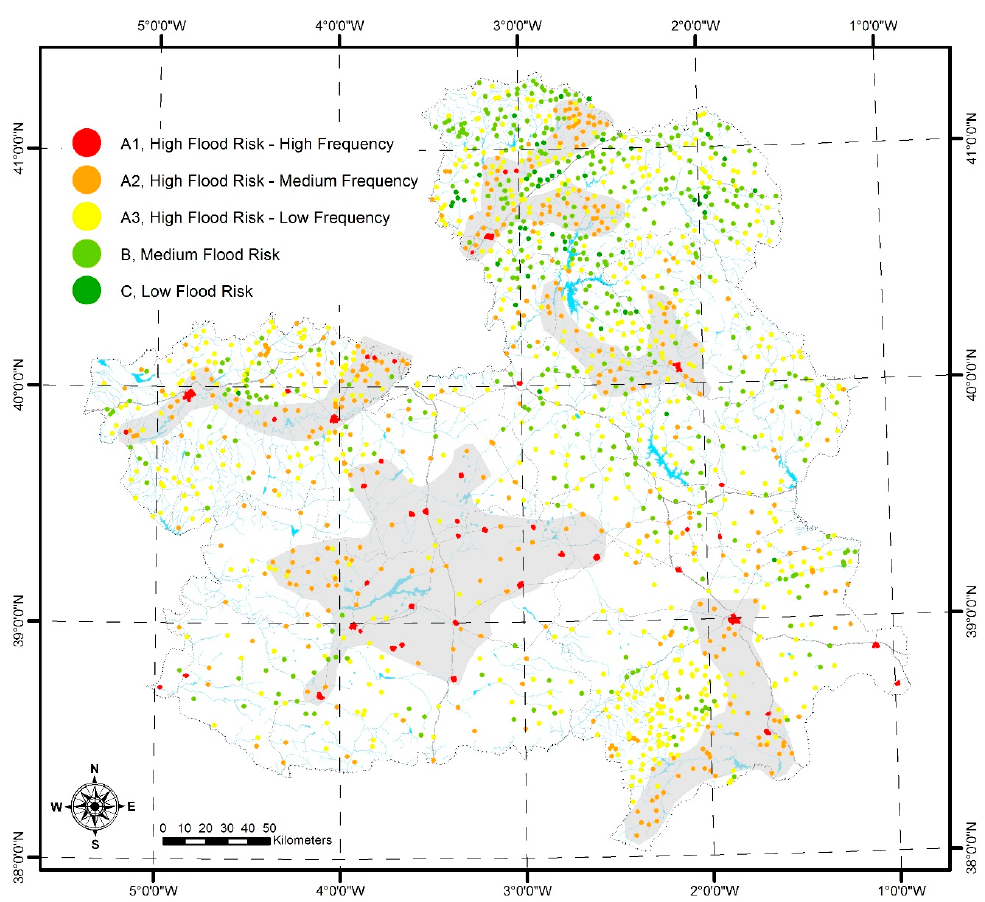
Figure 4. Urban centers flood risk classification for autonomous community of Castilla-La Mancha. Grey shadow areas show the flood risk high values concentration areas.